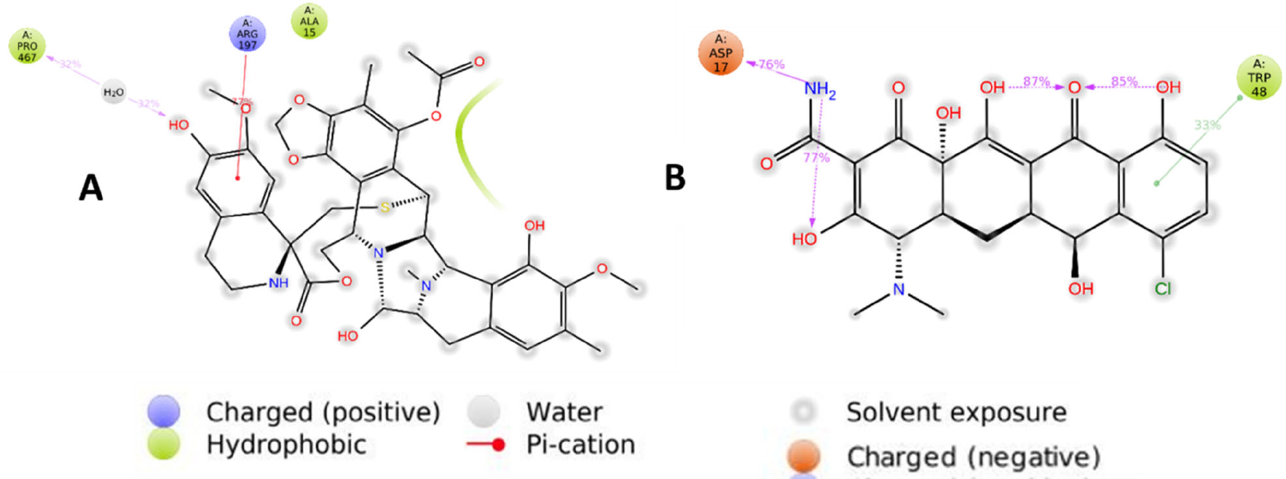
Figure 14. An interaction of less than 30.0% observed during the total simulation period between lead compounds Trabectedin ( A ), Demeclocycline ( B ), and the receptor.